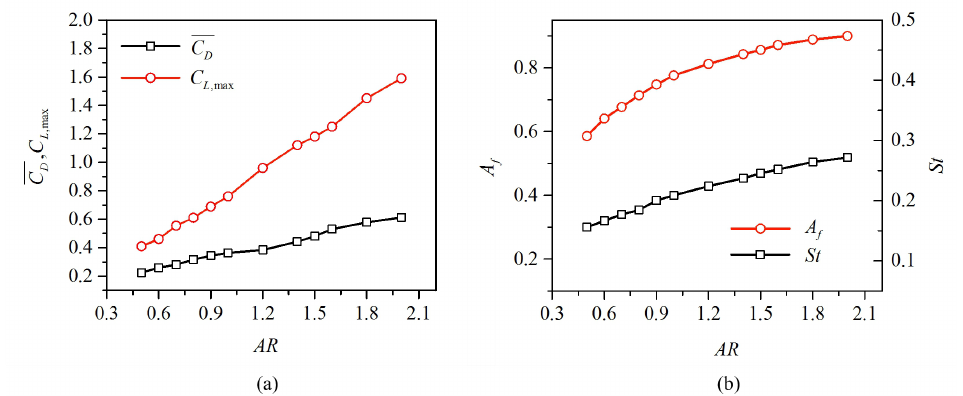
Figure 5. Force and displacement versus aspect ratio AR : ( a ) mean drag coefficient C D and maximum lift coefficient C L ,max ; ( b ) flapping amplitude A f and Strouhal number St